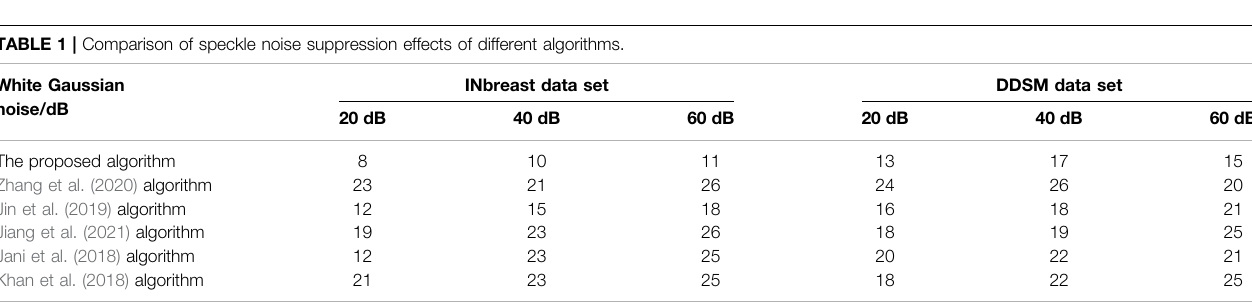
TABLE 1 | Comparison of speckle noise suppression effects of different algorithms. White Gaussian